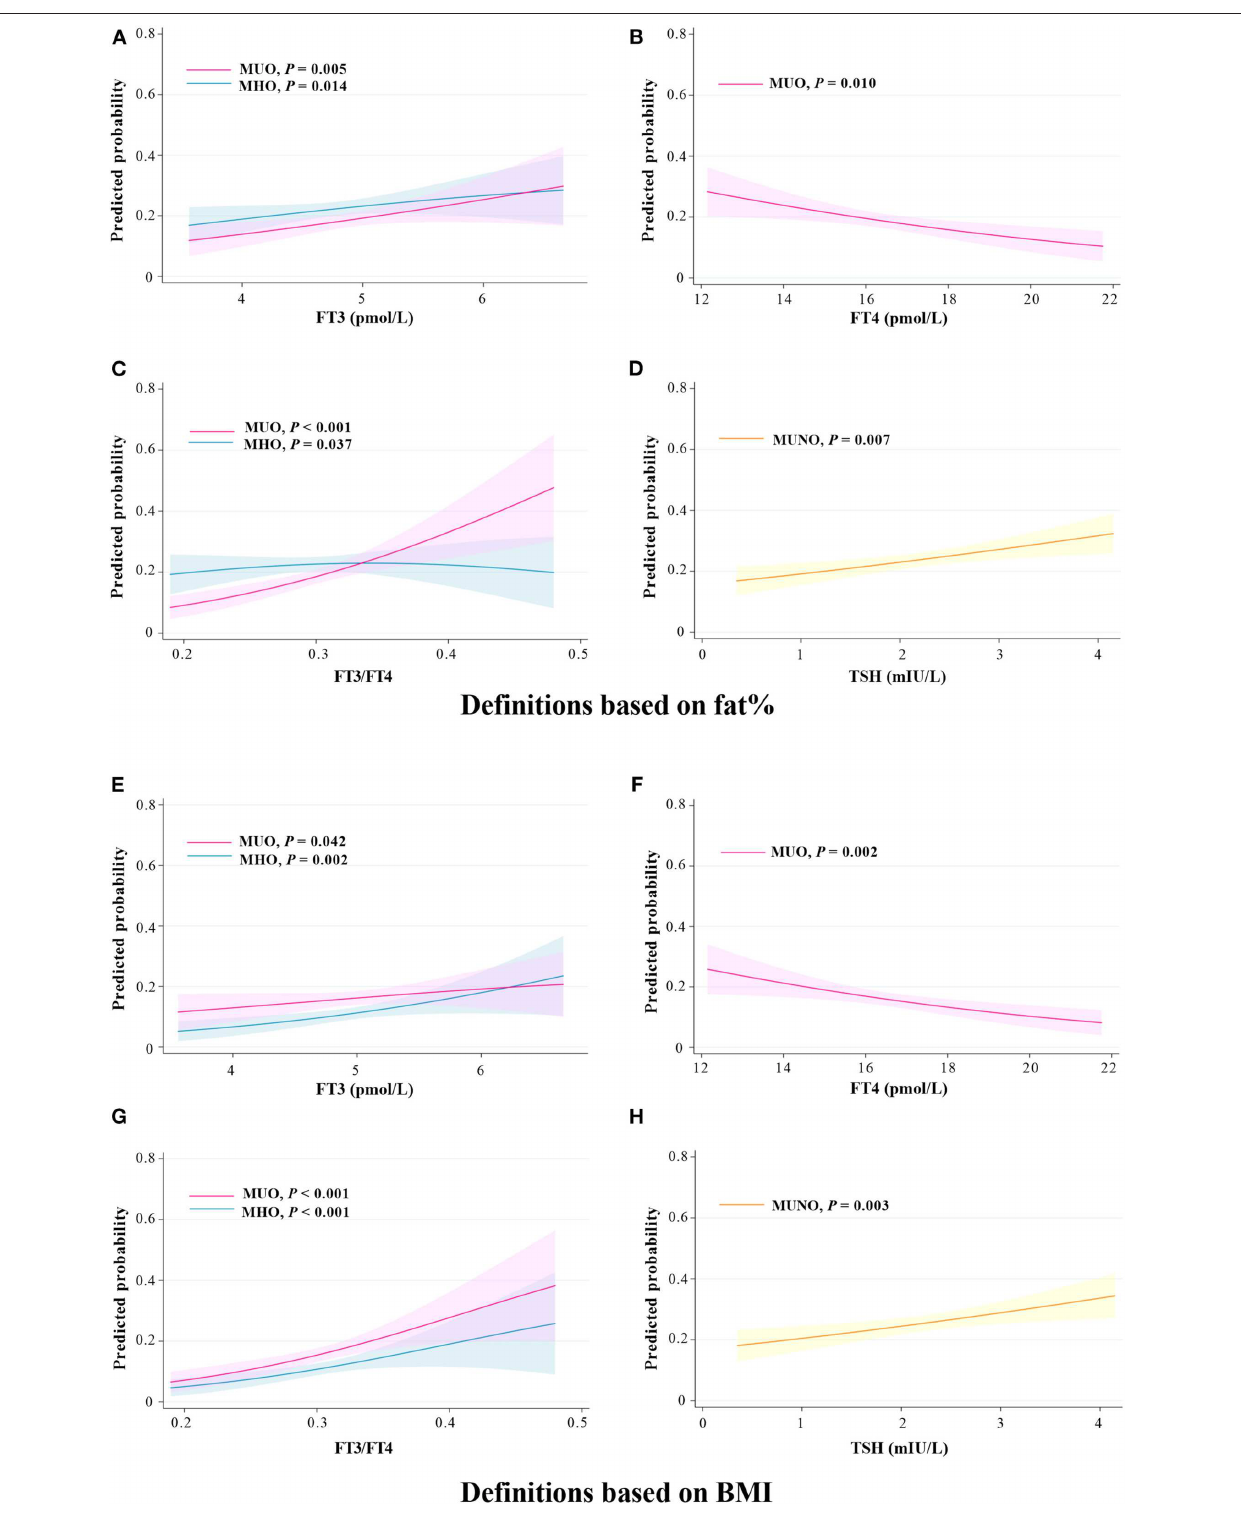
FIGURE 3 | Predicted probability of different metabolic phenotypes of obesity in relation to thyroid hormones. (A–D) Definitions based on fat%. (E–H) Definitions based on BMI. Predicted probabilities and 95% confidence intervals for the marginal effect of different metabolic phenotypes of obesity.